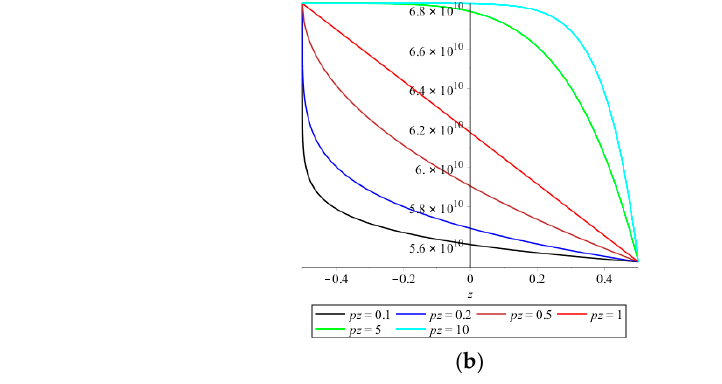
Figure A1. Young’s modulus evolution [Pa] of ( a ) FGM1-Z; ( b ) FGM2-Z. Similarly for the density, and for the same two cases (Equations (3) and (4)), the profiles are depicted in Figure A2.